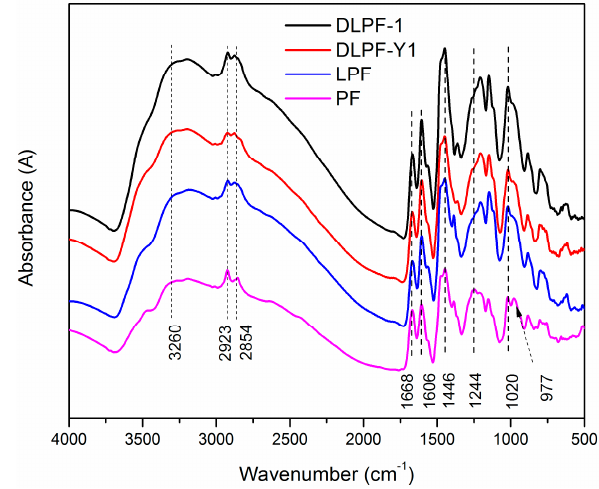
Figure 4. FT-IR spectra of phenol-formaldehyde (PF), lignin-phenol-formaldehyde (LPF), and demethylated lignin-phenol-formaldehyde (DLPF) resins.